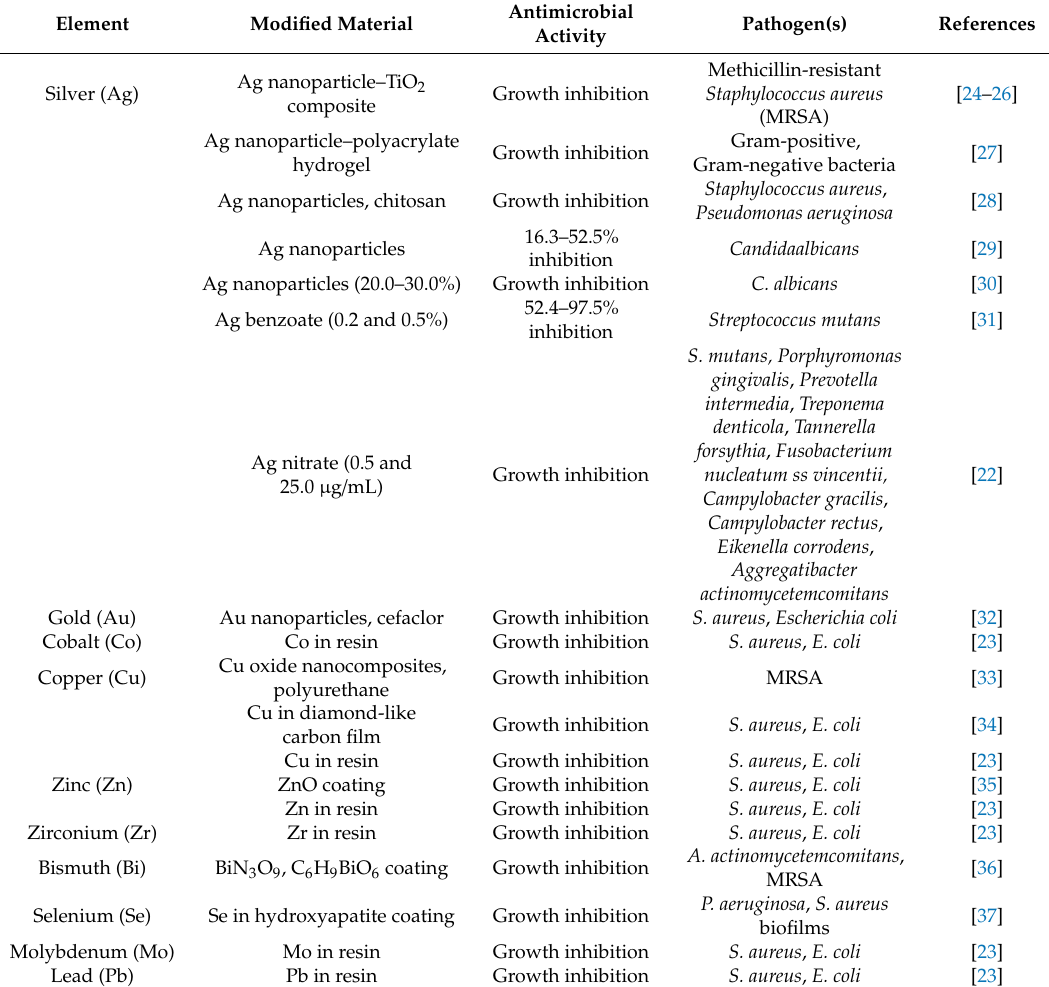
Table 1. Elements with antimicrobial activities used in bioactive